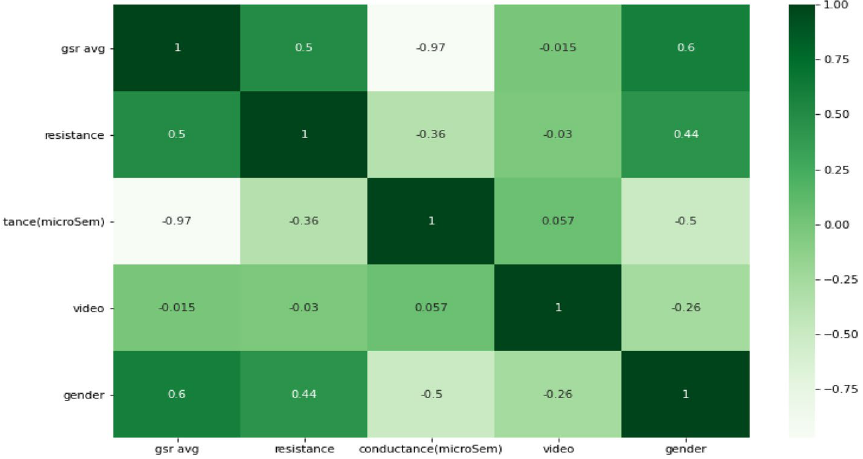
Fig. 23 Correlation matrix for GSR avg., resistance, conductance, video, and gender values from the correlation matrix. Following are the